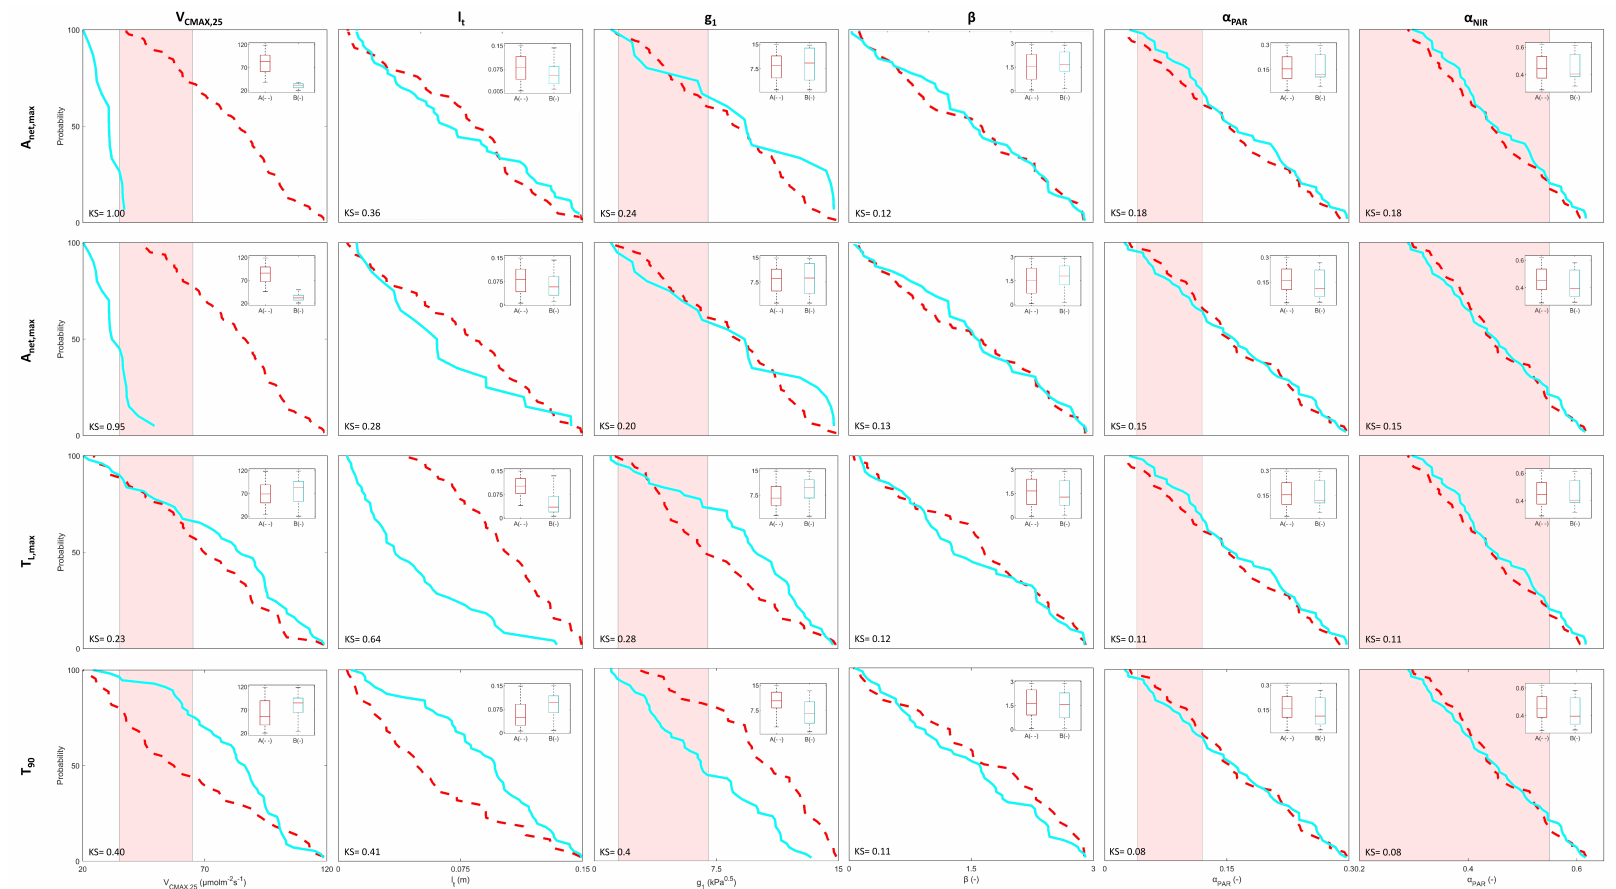
Figure 1. Results of the Global Sensitivity Analysis. Rows refer to the four metrics; columns to the six traits investigated. In each main plot, the lines are the empirical cumulative function of the trait values: blue solid lines refer to the trait values that lead to metric values below the metric-specific threshold; the red dashed lines refer to trait values that lead to metric values above the threshold. Shaded areas identify ranges of trait typically observed in mid-to-high latitudes. In the insets, the box and whisker plots compare and summarize the trait values leading to metric values above (left box; A–) and below (right box; B-) the threshold. The boxes extend from the first to the third quartile, the end of the whiskers are computed as 1.5 × IQR (Interquantile Range). The median values are indicated by the horizontal red